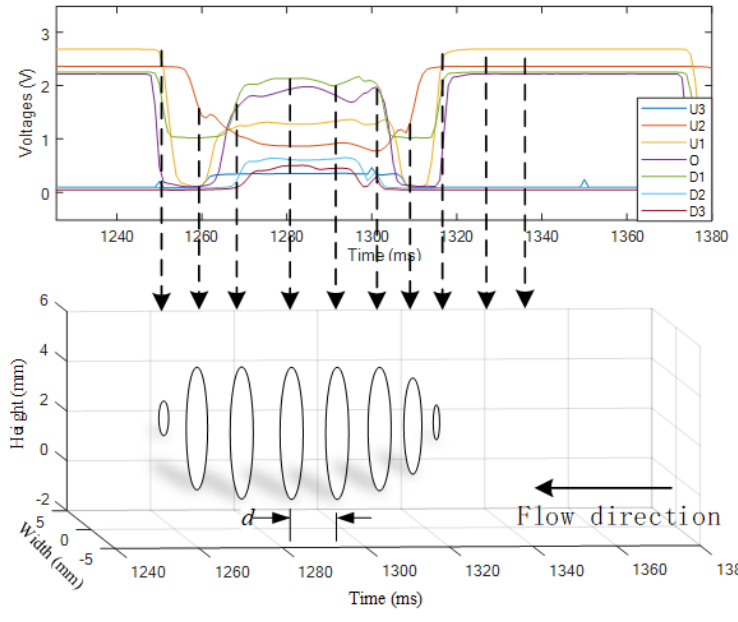
Figure 8. 2D reconstruction of the slug flow.